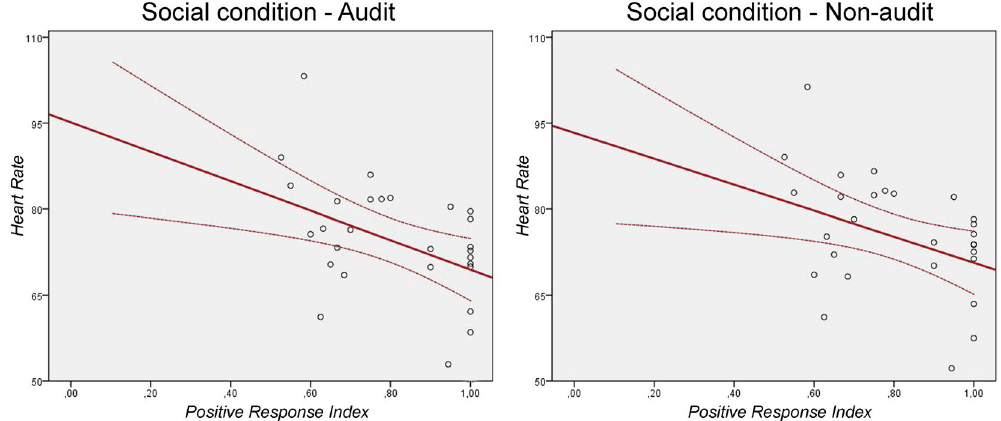
Figure 1. Significant correlations between the positive response index and heart rate values during both Audit (left panel) and Non-audit (right panel) trials of the Social condition. Solid lines represent global linear trends. Dashed lines represent 95% confidence